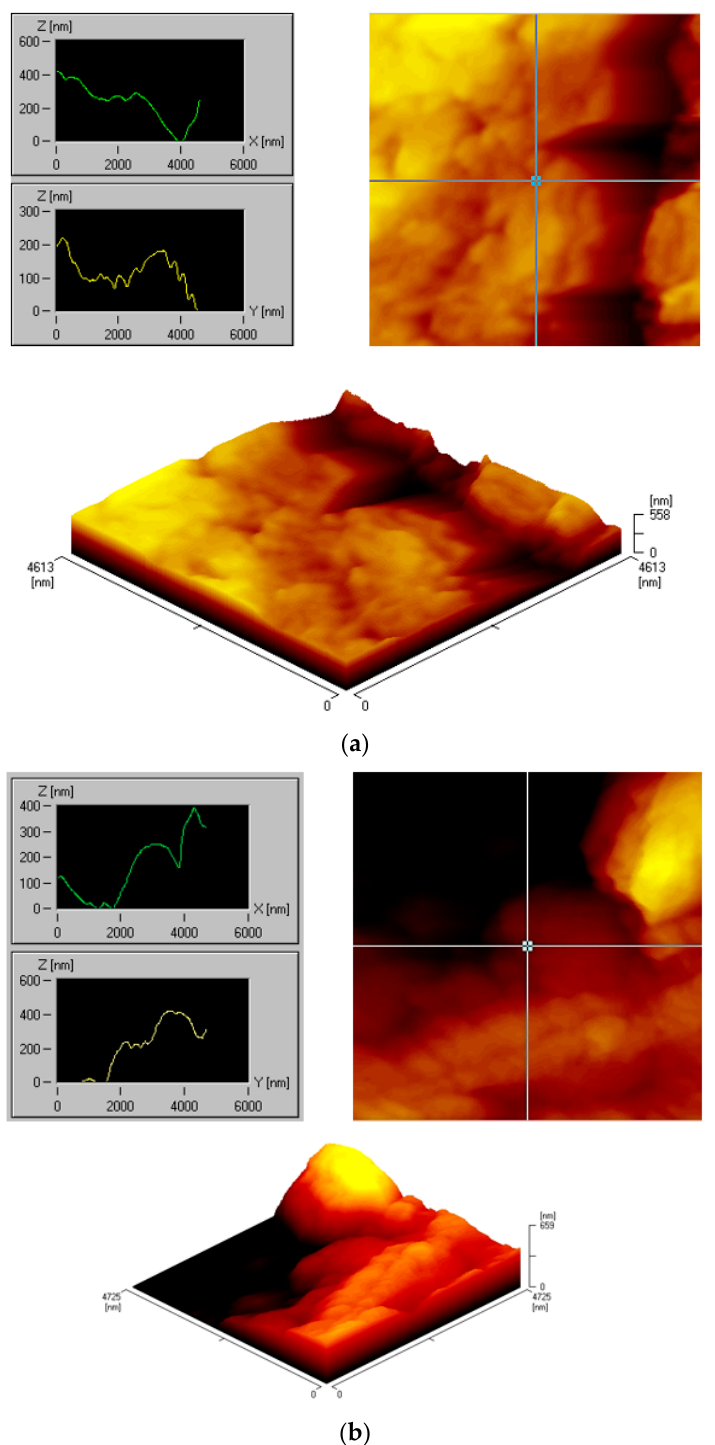
Figure 17. Ra profile on the spherical surfaces of ball joints for Nissan Maxima: ( a ) Right side; ( b ) Left side.